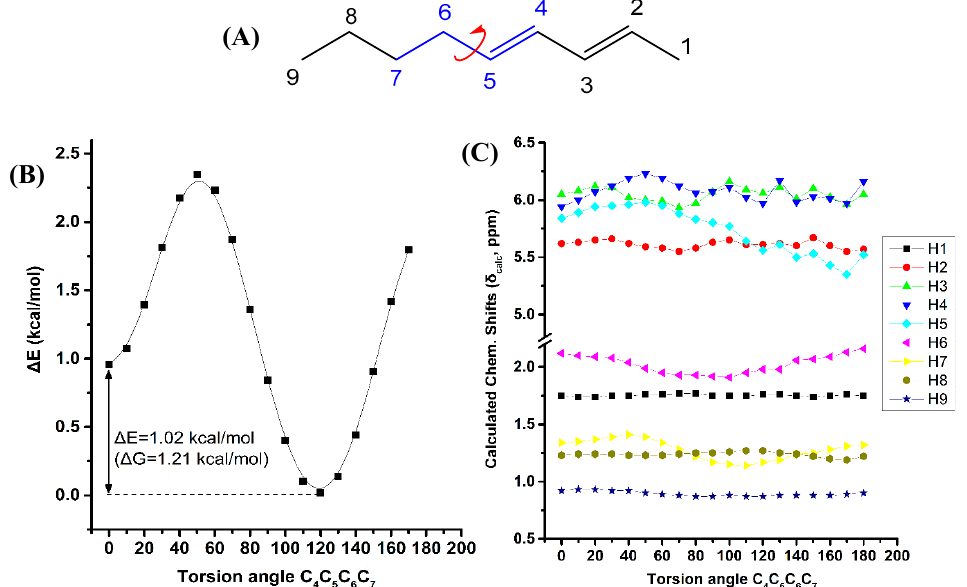
Figure 6. Effect of variation of the C 4 C 5 C 6 C 7 torsion angle of (E , E) -2,4-nonediene ( A ) on the electronic energy ∆ E(kcal · mol − 1 ) ( B ), and the 1 H-NMR chemical shifts ( C ) with energy minimization at the B3LYP / 6-31 + G(d) level. The Gibbs energy difference, ∆ G, of the two low energy conformers is also indicated.